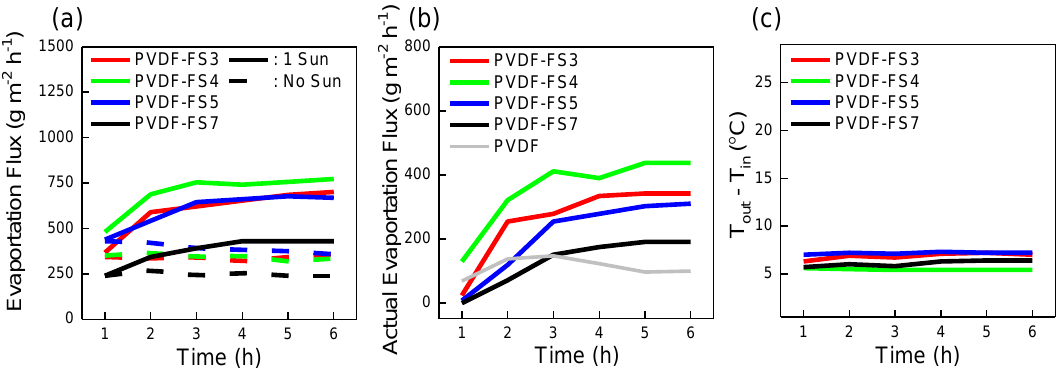
Figure 5. ( a ) Recorded mass flux over time with and without solar irradiation, ( b ) Calculated amount of flux driven solely due to 1 sun of solar irradiation, ( c ) Change in temperature showing that the heat accumulation due to heat transfer properties was negligible. The results indicate that all of our membranes were stable over 6 h, and that the PVDF-FS4 exhibited the highest performance as compared to the PVDF-FS3, PVDF-FS5, PVDF-FS7, and PVDF membranes.